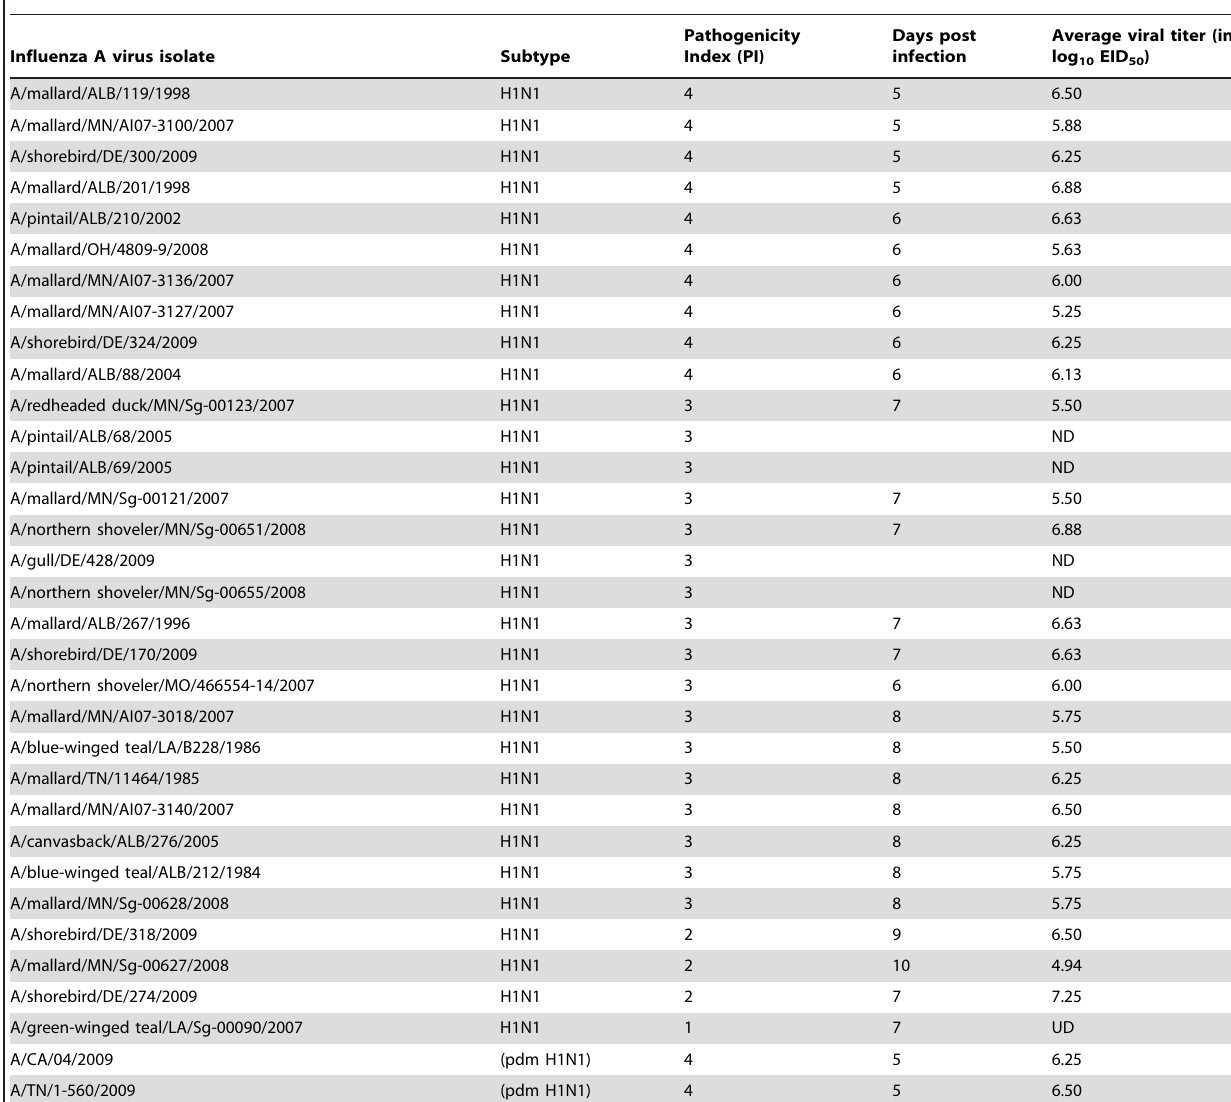
Table 3. Viral titers in the lungs of DBA/2J mice infected with avian H1N1 virus isolates from different pathogenicity levels. a